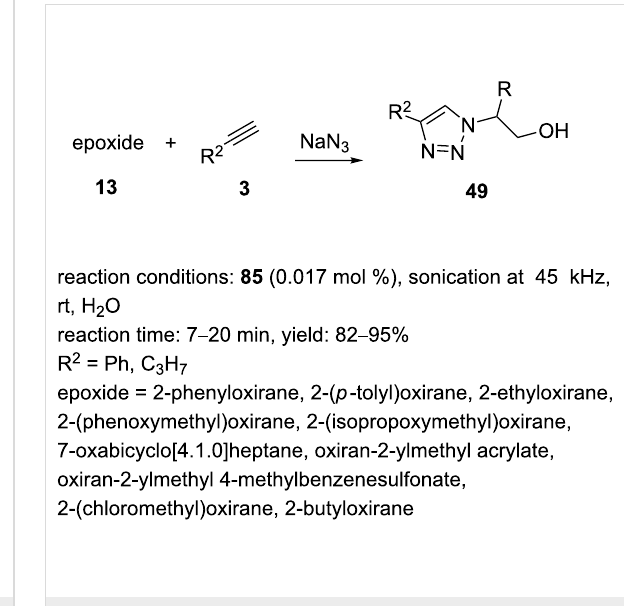
Scheme 17: Application of the catalyst 85 in “click”